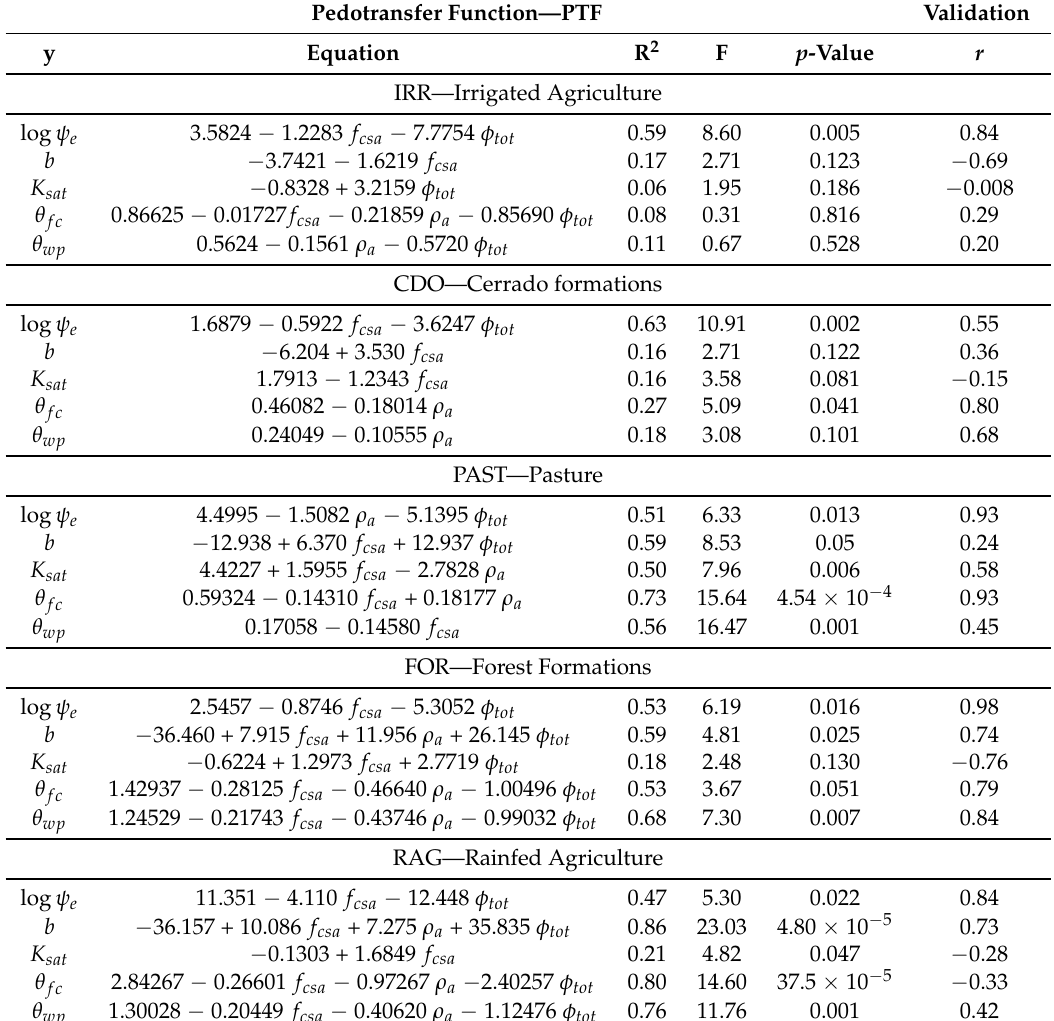
Table 2. Pedotransfer functions for Western